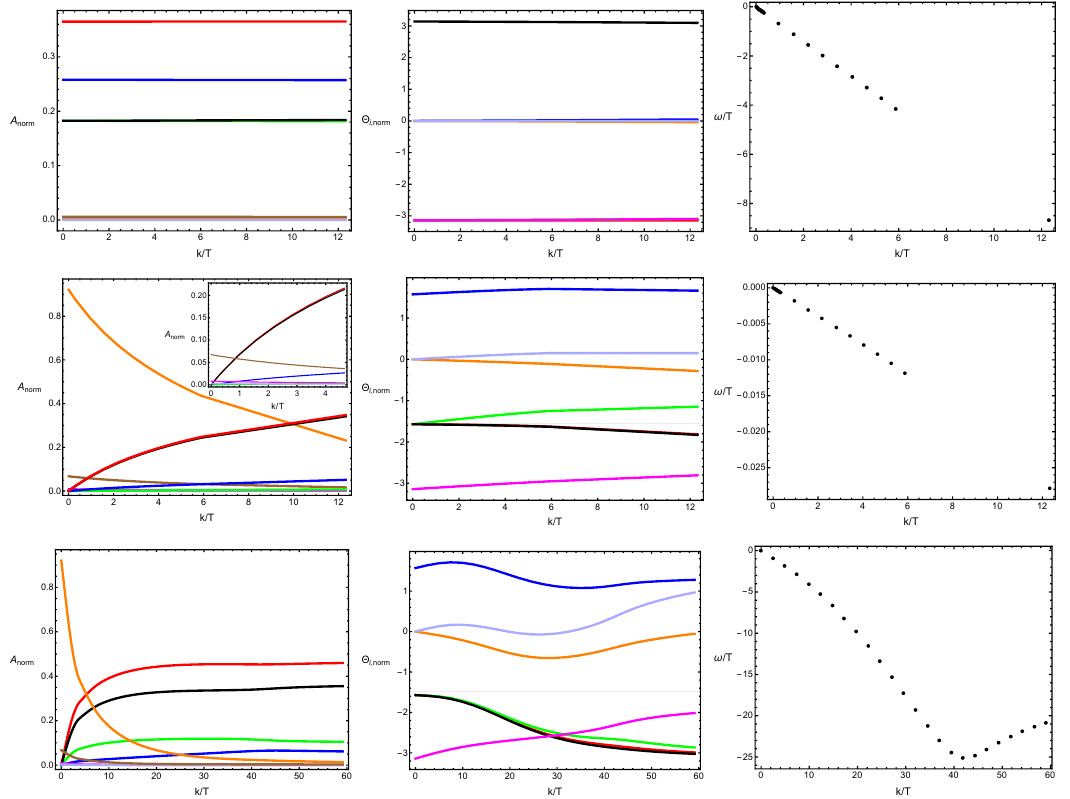
Figure 10 . The momentum dependence of the normalized amplitudes (4.7) at T/µ = 0 . 016 ( T/T c = 0 . 804) . Top panels : first sound. Central panels : second sound; the inset shows a zoom on small momenta (and we omit plotting the amplitude of the Higgs fluctuation in orange). Bottom panels : second sound beyond the linear part of the dispersion relation ( k/T (cid:29) 1